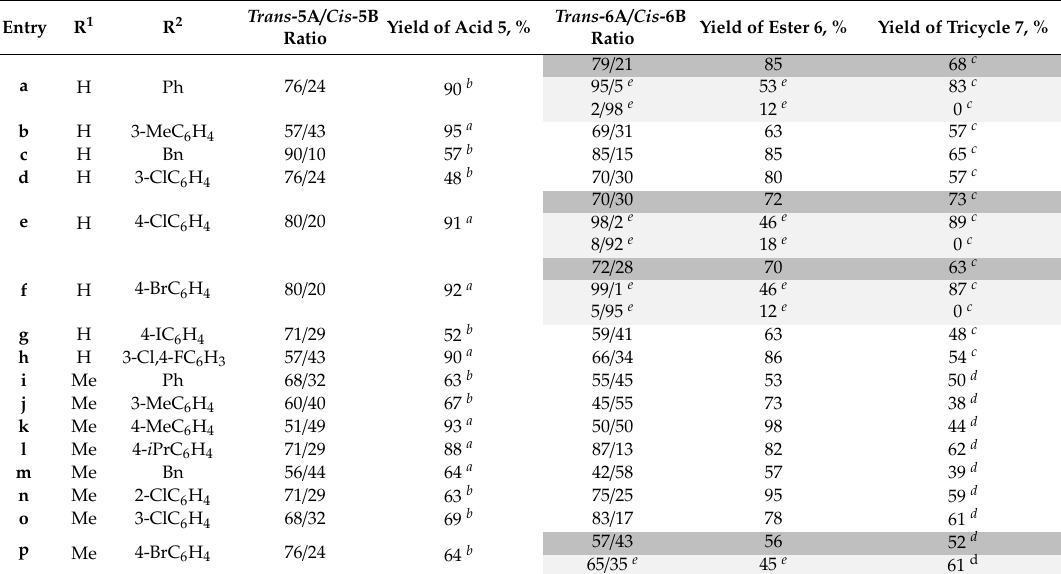
Table 2. Substituents R, isomer ratios, and yields for compounds 5 – 7.